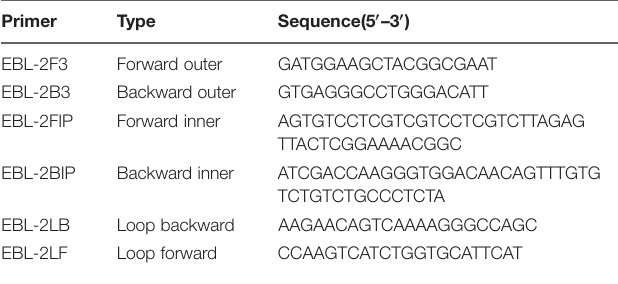
TABLE 1 | Sequence of primers used for specific amplification of NP